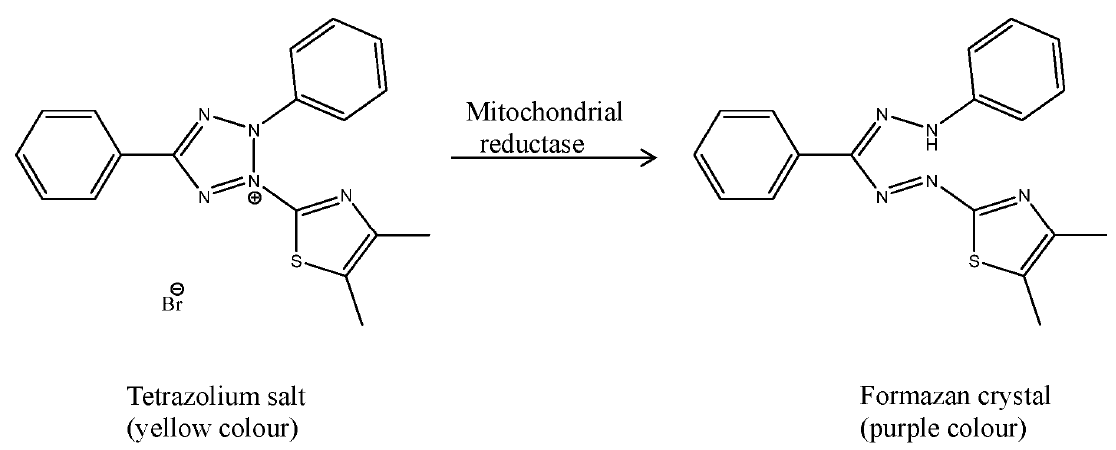
Figure 3. The formation of formazan crystals from the tetrazolium salt.